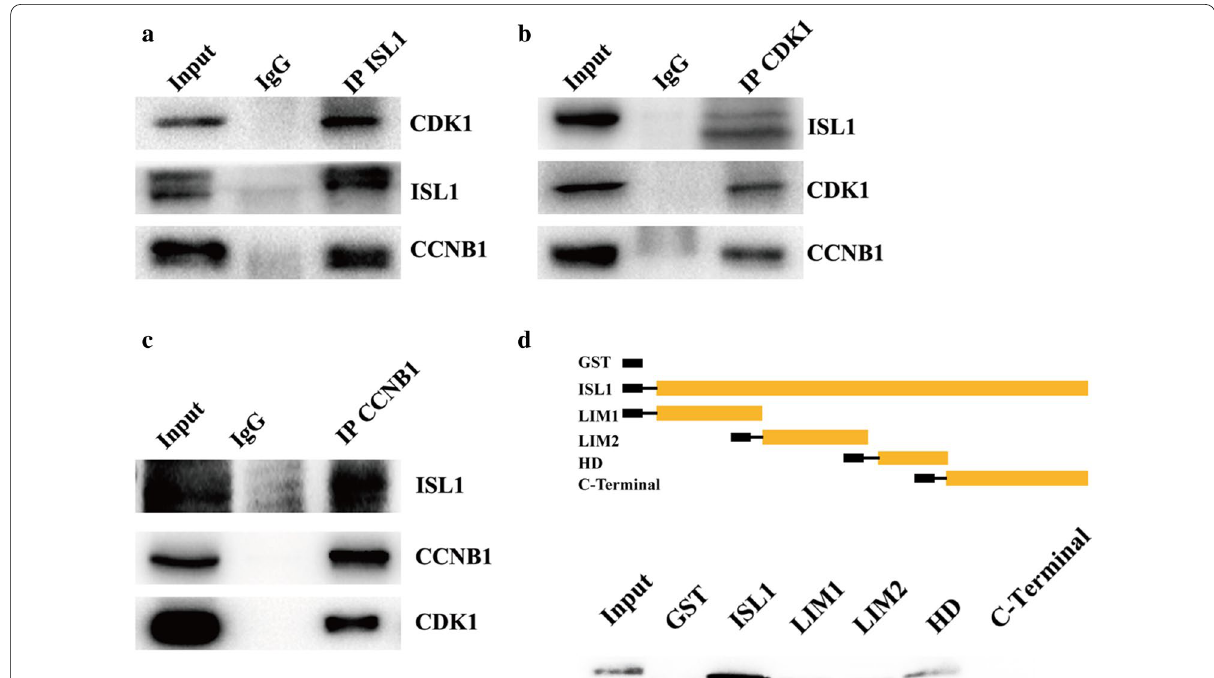
Fig. 1 ISL1 interacts with CDK1. a–c Co-IP assays were performed to measure the ISL1/CDK1/cyclinB1 complex in MGC803 cells. Lysate was immunoprecipitated with antibodies against ISL1, CDK1, or cyclinB1 and analyzed by immunoblotting. IgG: immunoglobulin G. d Full-length or truncated ISL1 was used to construct GST-fusion proteins (Top) for pull-down assays with CDK1 protein (Bottom)